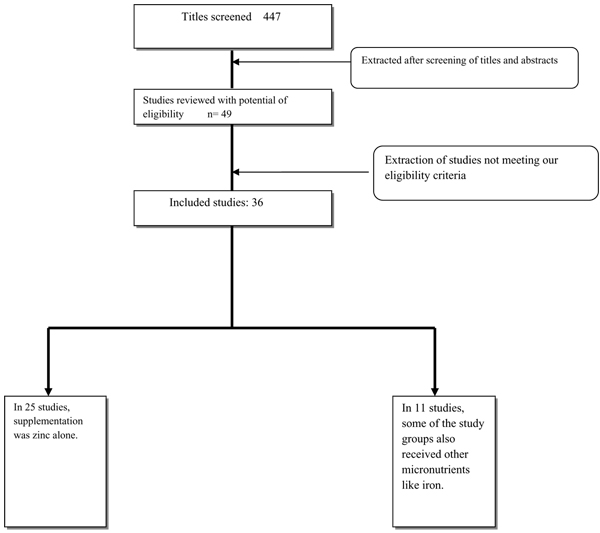
Synthesis of study identification in review of the effects of zinc supplementation on growth.